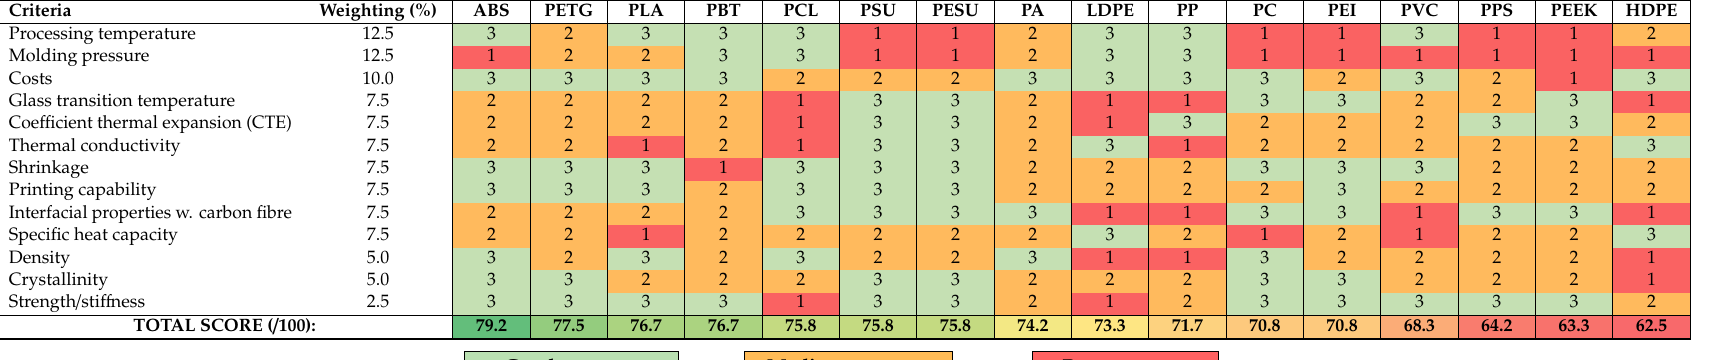
Table 2. Trade-o ff study of polymer matrices for ADFRCs suitable for 3D printing.